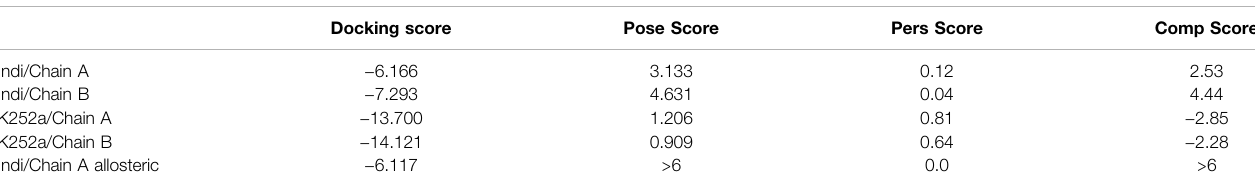
TABLE 1 | BPMD and docking scores for the Indicaxanthin and K252a